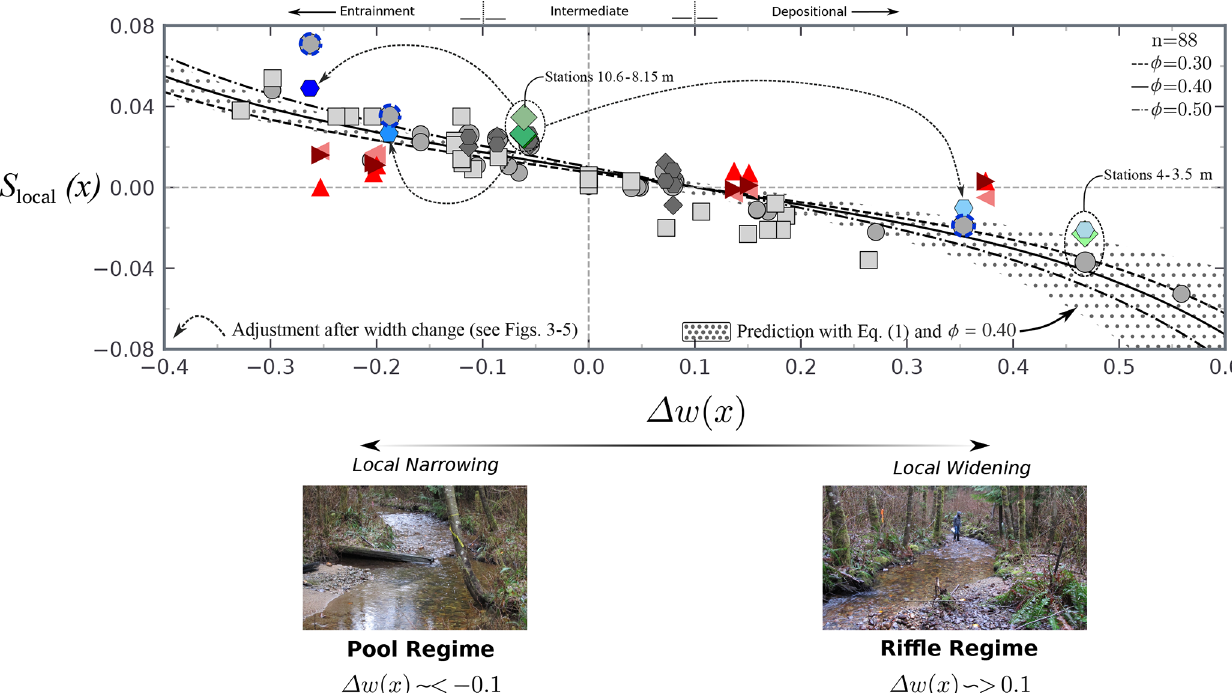
Figure 6. Local average bed slope S local ( x ) as a function of the downstream channel width gradient ∆w ( x ) for PRE4 and a wide range of additional field, numerical, and experimental studies. For the present experiment the symbols are used in the following way: the green diamond shows Phase 1 PRE4 and the blue hexagon shows Phase 2 PRE4 at locations where channel width is adjusted during the experiment, the dark gray diamond shows Phase 1 PRE4 and the dark gray hexagon shows Phase 2 PRE4 at locations where width remains unchanged during the experiment, and the light gray circle with dashed blue outline shows the result from Chartrand et al. (2018), which is comparable to PRE4 for the same downstream width gradient. For the literature-based data sets the symbols are used in the following way: the light gray circle represents Chartrand et al. (2018), which includes data from Thompson et al. (1999) (field), de Almeida and Rodríguez (2012) (numerical), Bolla Pittaluga et al. (2014) (numerical), and Nelson et al. (2015) (experiment); the light gray square includes data from Richards (1976) (field), Cao et al. (2003) (numerical), and Vahidi et al. (2020) (experiment). The pink triangle represents the period before the Elwha and Glines Canyon dams were removed on the Elwha River, the red triangle shows data following the removal of the Elwha dam and all but 9.1m of the Glines Canyon dam in the spring prior to the freshet floods, and the dark red triangle shows data taken in the late summer after the freshet floods and with the remaining 9.1m of Glines Canyon dam still in place. All three of these use data from Brew et al. (2015) (field). See Appendix A for more details regarding the literature-based data sets (light gray squares). Plotted lines represent the center of a distribution of predicted values using Eq. (1) for differing values of the packing fraction ε . See Appendix A and the online repository (Chartrand et al., 2022) for the calculation procedure of Eq. (1). The distribution of predicted values is shown with hatching for φ = 0 .